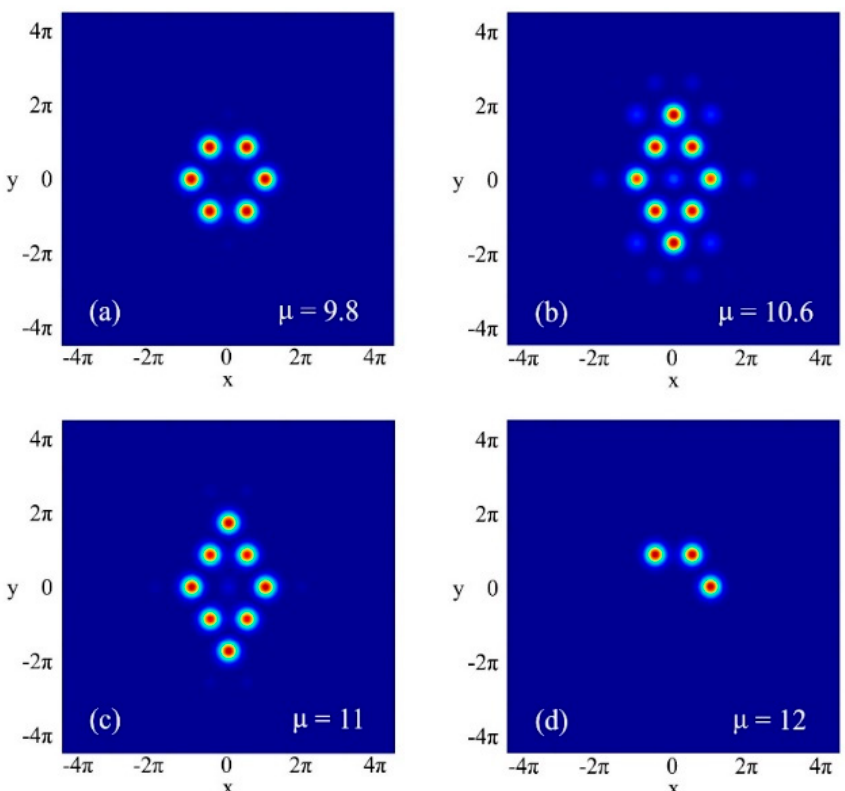
Figure 13. The evolution of the profiles of vortex solitons with d = 2, m = 2. ( a – d ) are the profiles of the vortex solitons with µ = 9.8,10.6,11,12, respectively. The upper row corresponds to solitons in the first bandgap, while the lower row corresponds to solitons in the infinite bandgap.